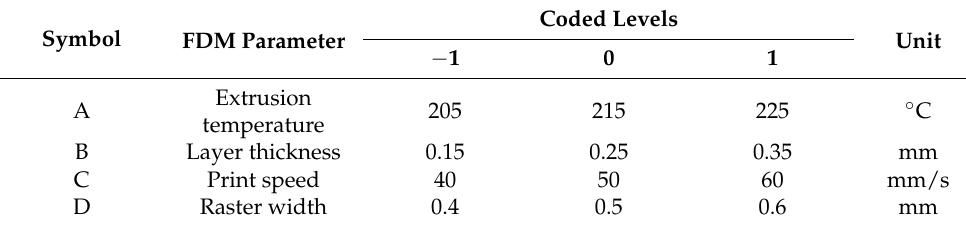
Figure 2. Graphical representation of FDM parameters. Table 1. FDM parameters and their levels.